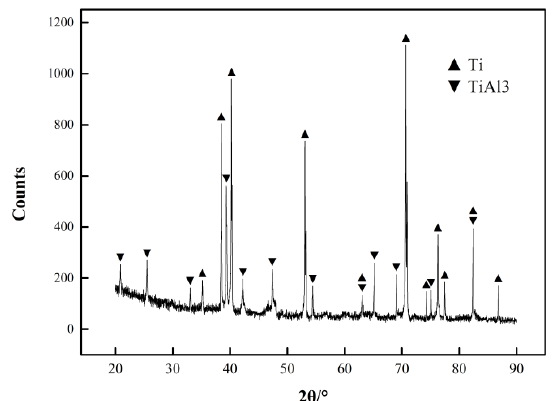
Figure 7. Results of the X-ray diffraction (XRD) test in the bonding layer of the Ti/Al laminated